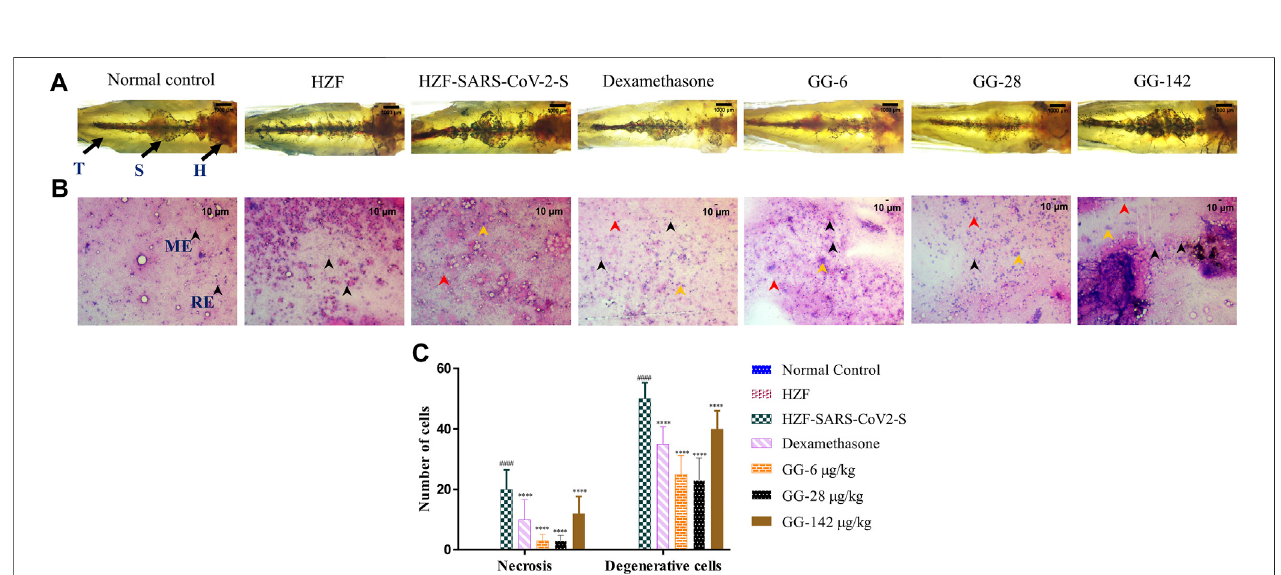
FIGURE6| 7-daystimepointshowingchangestokidneymorphology,cytology,andquantitativeanalysisofdamage. (A) Structuralexaminationofthekidneyat1X using transmitted light. Granular appearance shows the presence of melanocytes. (B) Cytological examination of hematoxylin-eosin stained smears of kidney tissue imaged at × 20 objective magni fi cation. Black arrowheads depict nuclei of normal cells, yellow show degenerative cells while red show necrotic cells. (C) Quantitation of kidney damage as assessed by the presence of degenerative and necrotic cells in cytological smears. Data points represent mean ± S.D. analyzed by Two-Way ANOVA followed by Tukey ’ s multiple comparisons test (****) p < 0.0001 compared to disease control, n (cid:2) 24.